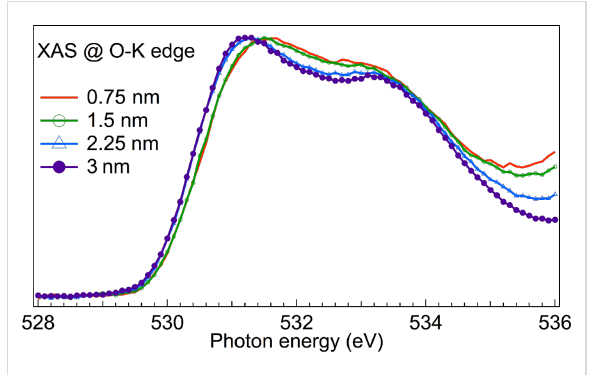
Figure 4: Detailed view of feature C. The spectra were normalized in order to distinguish line-shape changes.